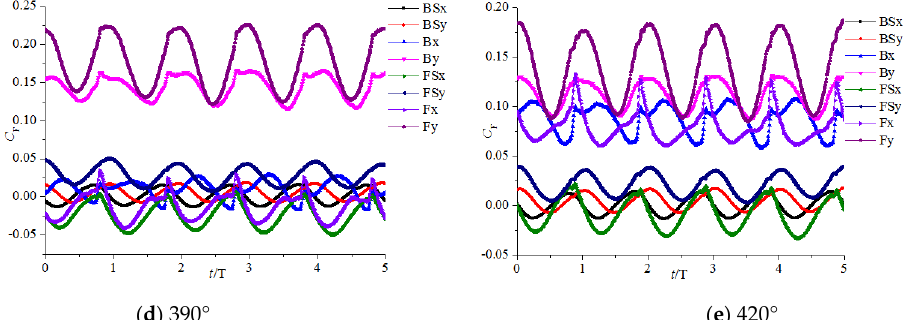
Figure 11. Radial force of a single centrifugal impeller with different wrap angles under the designed flow rate condition. Figure 12 shows the radial force F r curve of the impeller with different blade wrap angles when the impeller rotates. The calculation results are adopted the dimensionless coefficient C F .